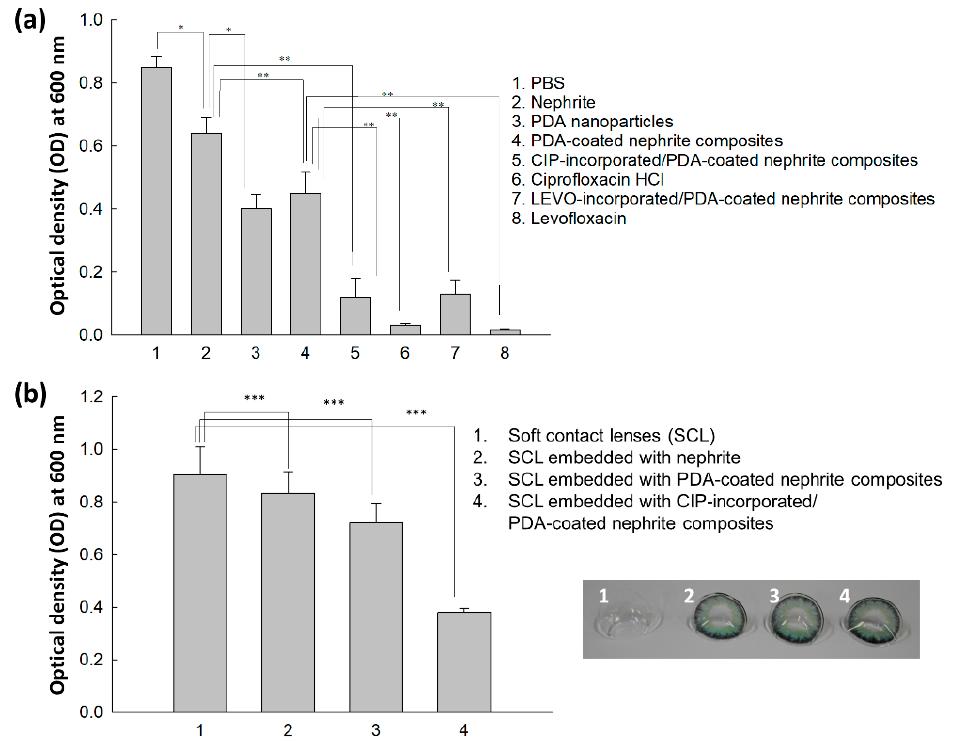
Figure 6. Antibacterial activity of CIP-incorporated/PDA-coated nephrite composites (CIP/dopamine/nephrite ratio = 0.2/1.0/1.0) against S. aureus in vitro ( a ). CIP or LEVO dosage was adjusted to 5 µ g/mL. Dosage of PDA nanoparticles was 50 µ g PDA/mL. Dosage of PDA-coated nephrite composites was 100 µ g/mL. *, **: p < 0.01. Antibacterial activity of soft contact lenses (SCL) embedded with CIP-incorporated/PDA-coated nephrite composites (CIP/dopamine/nephrite ratio = 0.2/1.0/1.0) against S. aureus in vitro ( b ). ***: p < 0.01. To evaluate the sustained release properties of CIP-incorporated/PDA-coated nephrite composites against bacterial growth, they were introduced into a dialysis membrane and then media were exchanged to mimic an in vivo environment as shown in Figure 7. As shown in Figure 7, PBS or PDA-coated nephrite composites did not practically affect the growth of bacteria while CIP-incorporated/PDA-coated nephrite composites signifi- cantly inhibited bacterial growth. Even though free-CIP treatment also inhibited bacterial growth initially, the extent of bacterial growth was five times higher than the treatment of CIP-incorporated/PDA-coated nephrite composites. These results were due to the sustained drug release properties of CIP- or LEVO-incorporated/PDA-coated nephrite composites; thus, they maintained antibacterial activity during the fabrication process or drug release